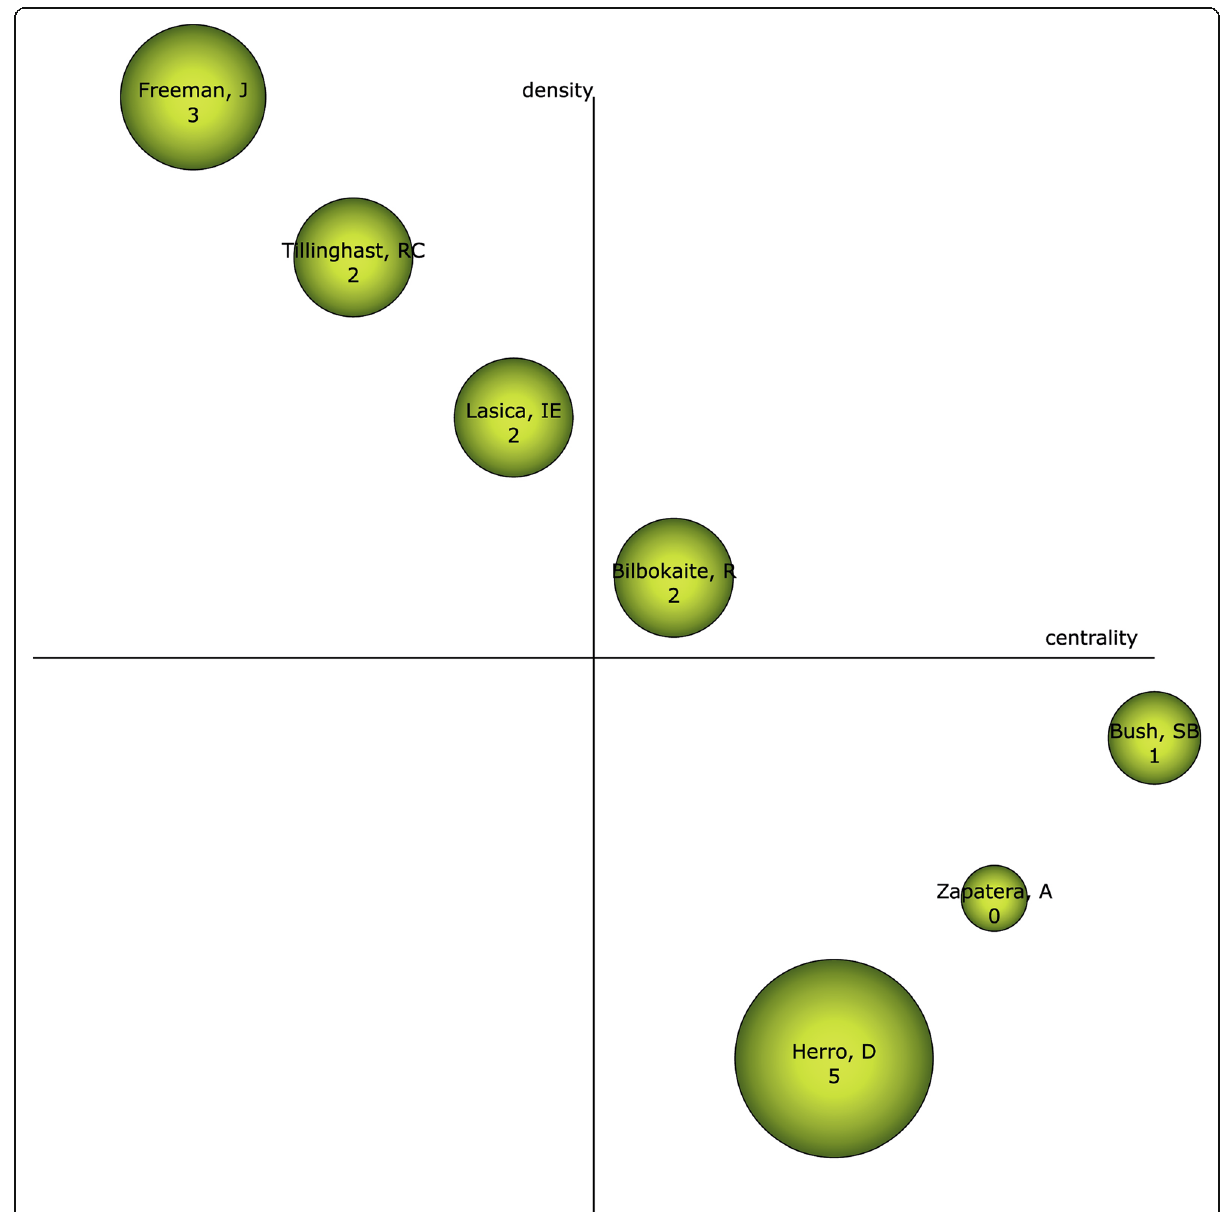
Fig. 9 Strategic diagram by h-index of authors of all scientific